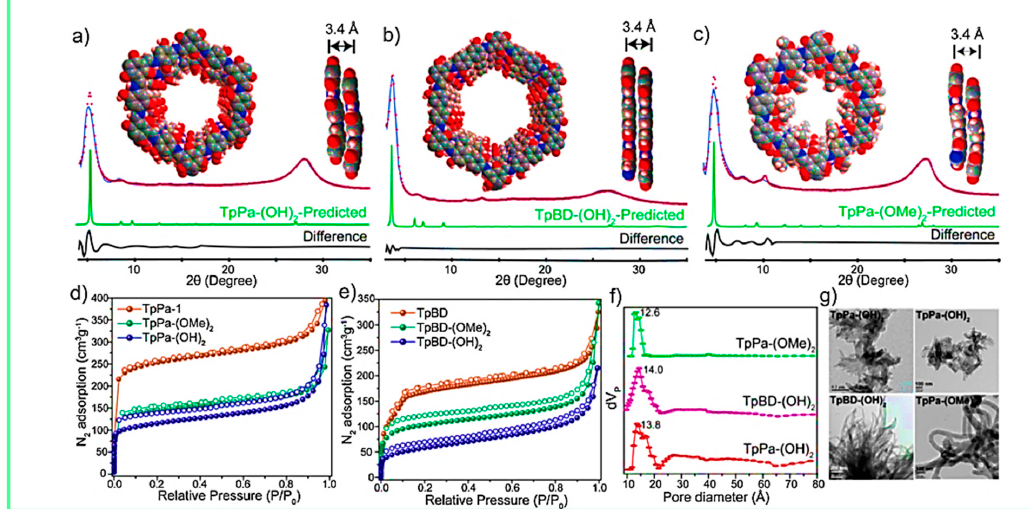
Figure 22. Evaluation of the observed (blue), predicted (green), and refined (red) PXRD patterns with their alteration (black) for ( a ) TpPa-(OH) 2 , ( b ) TpBD-(OH) 2 , and ( c ) TpPa-(OMe) 2 . Inset figures display the pore structure and π−π stacking distance for each of the COFs. Comparison of N 2 adsorption isotherms at 77 K for ( d ) TpPa series [TpPa-(OH) 2 (blue), TpPa-(OMe) 2 (green), and TpPa-1 (brown)] and ( e ) TpBD series [TpBD-(OH) 2 (blue), TpBD-(OMe) 2 (green), and TpBD (brown)]. ( f ) Pore size distribution and ( g ) TEM images for TpPa-(OH) 2 , TpBD-(OH) 2 , TpPa-(OMe) 2 , and TpBD-(OMe) 2 . Reprinted with permission from [442], Copyright 2017, American Chemical Society.